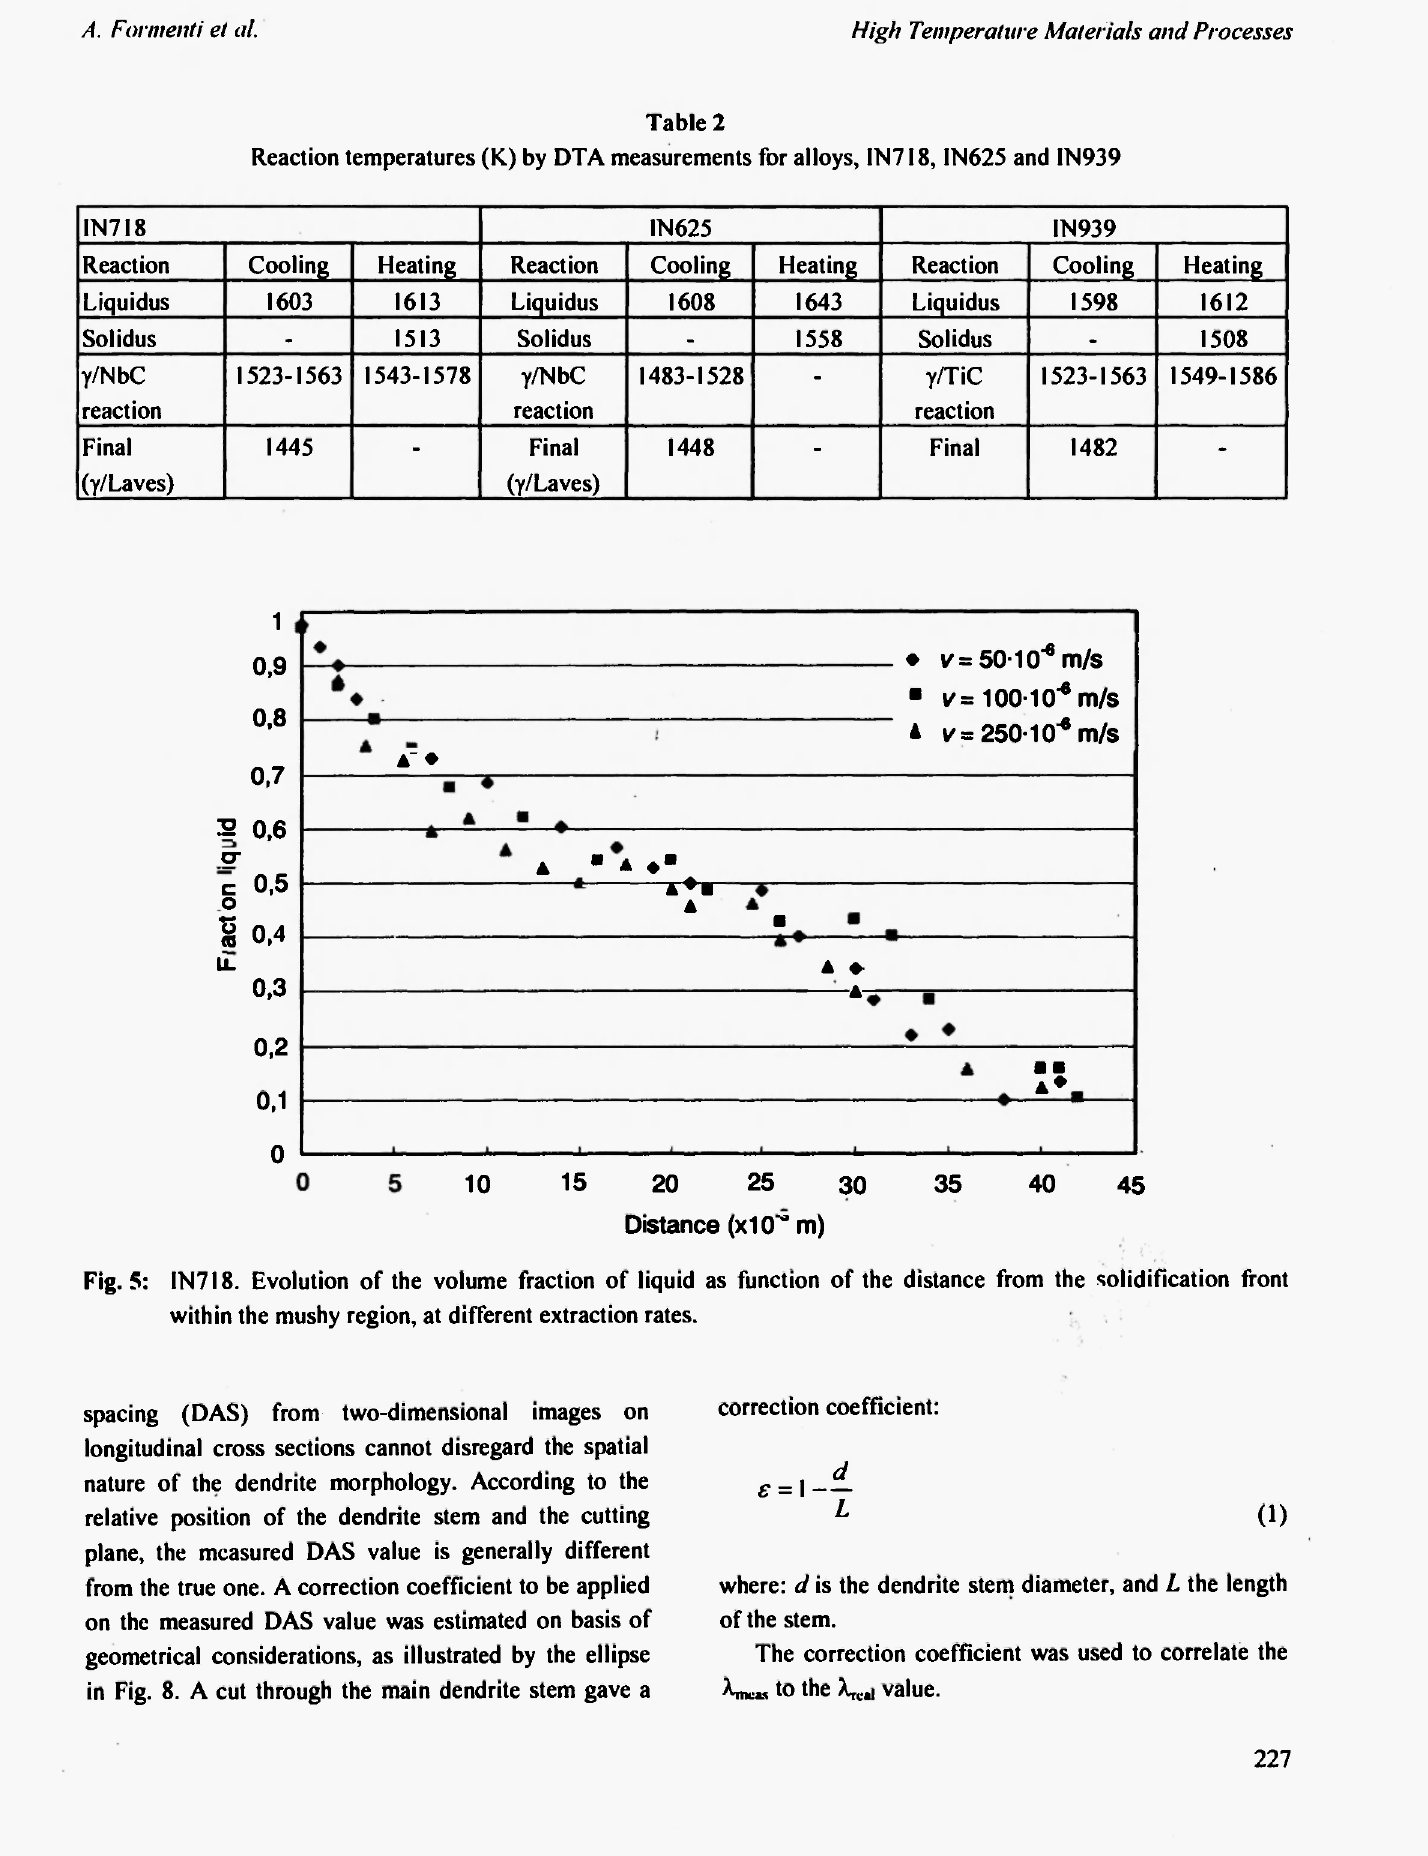
Fig. 5: IN718. Evolution of the volume fraction of liquid as function of the distance from the solidification front within the mushy region, at different extraction